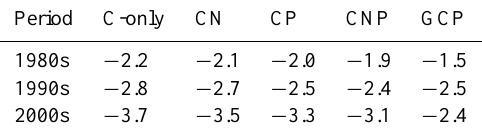
Table 4. Simulated decadal land C uptake (Gt ( C ) yr − 1 ) with and without accouting for nutrients compared to published estimates of the natural terrestrial sink from the Global Carbon Project (GCP) (Friedlingstein et al., 2010). Note that we omit land use (change) in our simulations.